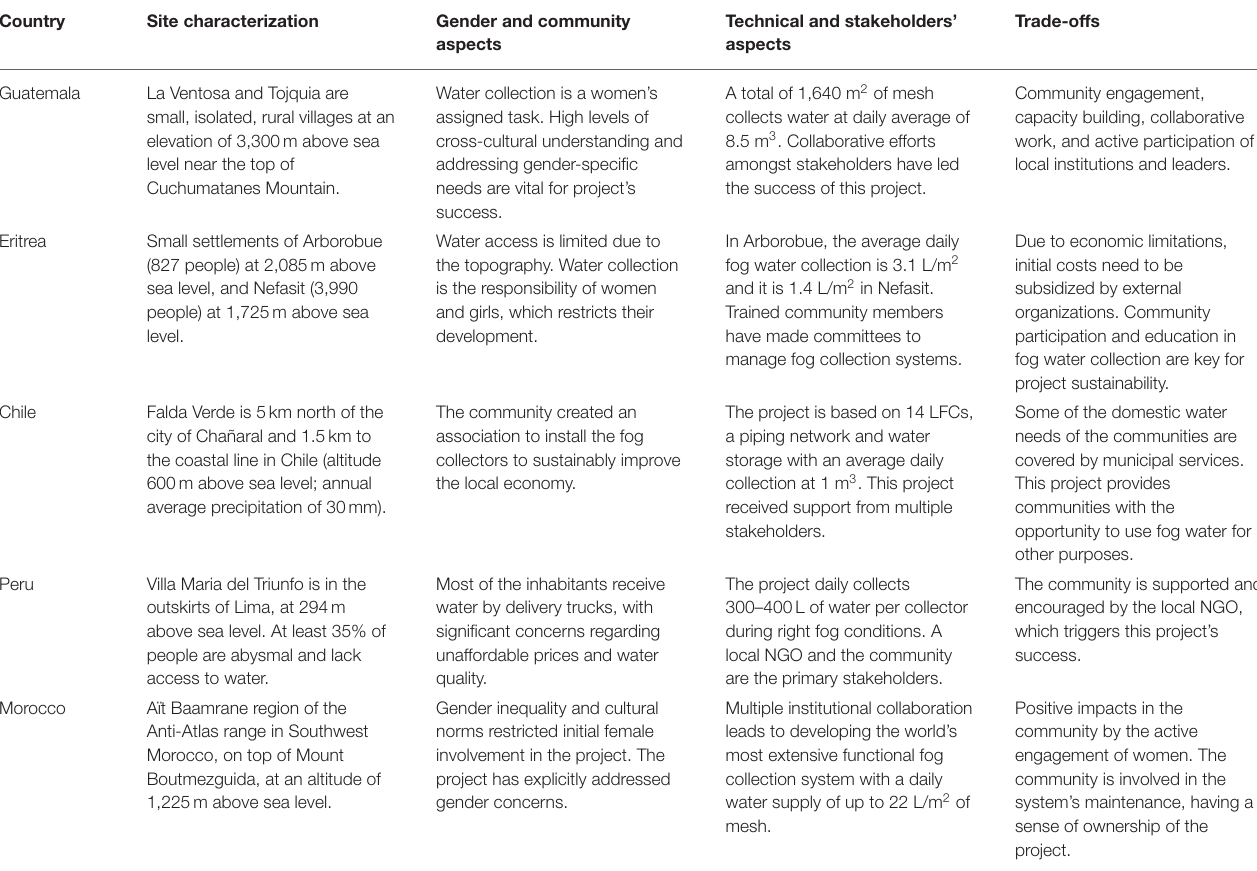
TABLE 1 | Summary of key aspects of functional systems of fog water